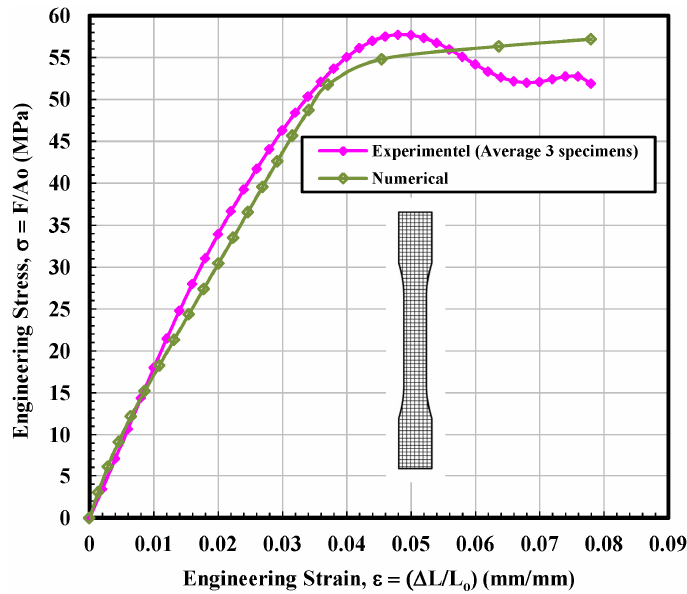
Figure 11. Engineering stress–strain curves for solid tested specimens based on experimental and finite element analysis.